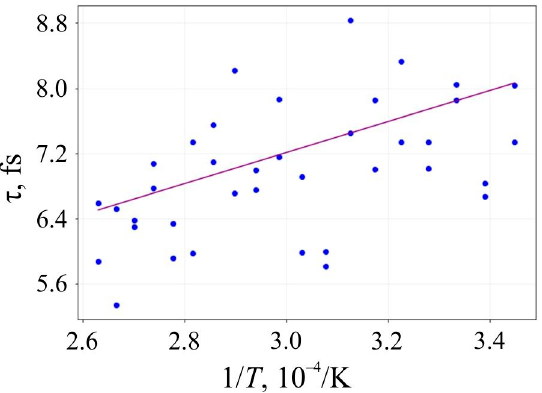
Figure 6. Lifetime of the 6,6,12-graphyne before its decomposition versus the inverse initial temper- ature T − 1 : circles are the results of the numerical calculation, and a solid line is the corresponding linear approximation obtained by the least-square method.